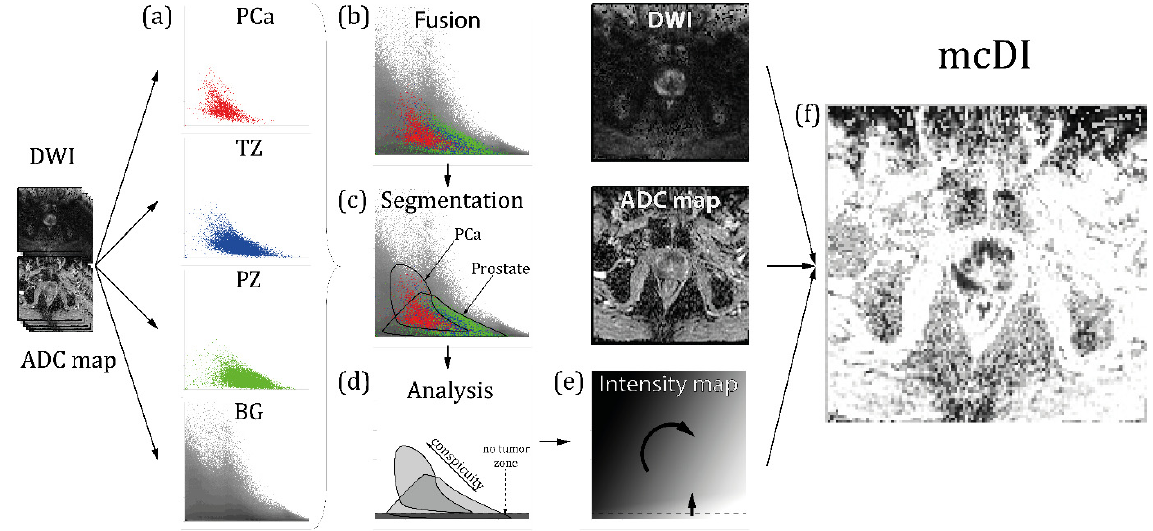
Figure 2. Creation of the map and the mcDI. ( a ) The ADCs of 70 patients are segmented to create four different 2D histograms (prostate cancer (PCa), red; peripheral zone (PZ), green; transitional zone (TZ), blue; and background (BG), gray). See Figure 1 for further information. It is important to note that the pixel brightness is dictated by the number of voxels plotted into one pixel; the darker the pixel, the more voxels it represents. Due to the exponential representation, every brightness step represents an exponential increase in the voxel density; ( b ) Fusion: The four 2D histograms are fused to show all the tissues in a single image (for demonstration purposes, a simple image overlay was chosen); ( c ) Segmentation: The respective areas are segmented into the tumor voxel (PCa) and prostate tissue; ( d ) Analysis: The segmented areas are analyzed. In concordance with the clinical knowledge, we found that the tumor voxel had an extensive range of DWI and ADC values. However, no tumor was found below a certain DWI threshold, which defined the ‘no-tumor zone’. Furthermore, the conspicuity of the tumor voxels increased with the increasing intensity in the DWI and decreasing intensity in the ADC; ( e ) Map: These findings were used to create a map that forms the basis of the multichannel computed diffusion images (mcDI). The no-tumor zone was implemented by suppressing the low DWI values. For that purpose, a gradient was used with decreasing brightness correlating to the increasing DWI values. We chose hypo-intensity to represent conspicuous areas, so the resulting mcDI has an ADC-like appearance. However, inverted intensity maps can also be used to generate a more DWI-like image. Since our images exhibit ADC-like character- istics, the main gradient runs vertically from black (ADC = 0) to white (ADC = 1). To include the DWI information, the gradient was tilted clockwise. It is important to notice that the increasing sig- nal in the DWI corresponds to the decreasing intensity in the mcDI; ( f ) mcDI: The mcDIs are created by reversing the algorithm of the histograms and plotting the intensity of the corresponding location on the map back to the final image. Compared to the ADC, the signal of the fatty tissue and bones is suppressed (lighter), while the tumor tissue is even darker than in the original ADC. The effect on the DWI can be best seen in the reduction of the T2 shine-through.